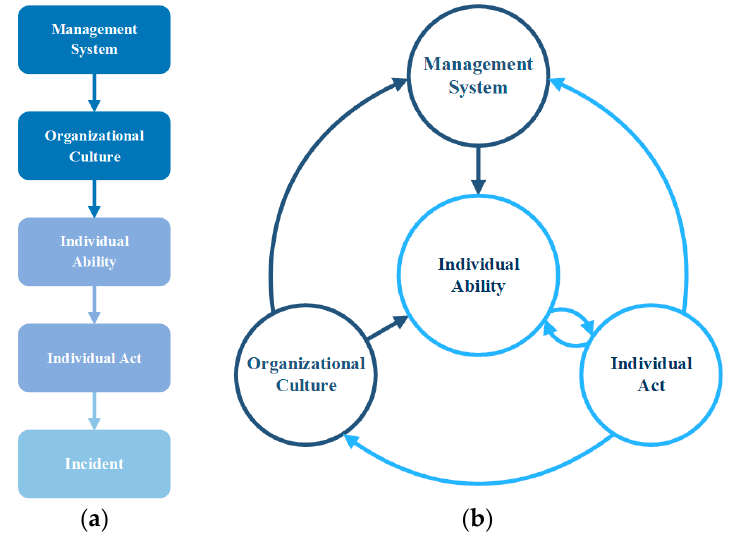
Figure 2. ( a ) Sixth edition of the 24Model (static); ( b ) sixth edition of 24Model (dynamic).